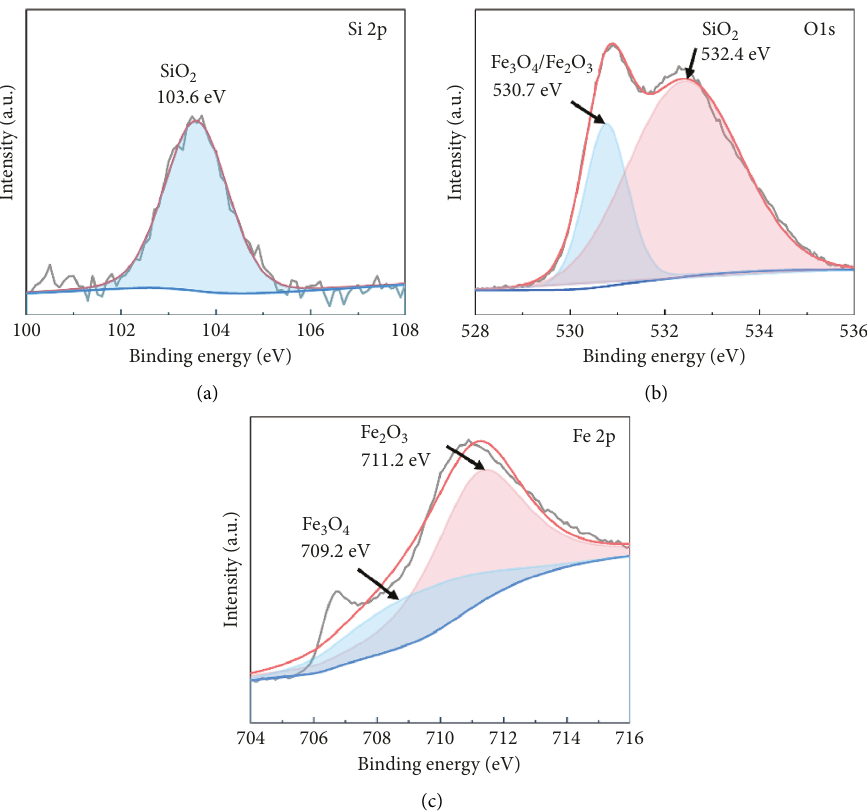
Figure 10: An XPS spectra of Si 2 p, O 1s, and Fe 2 p on the wear surface lubricated with 0.3 wt.% SiO 2